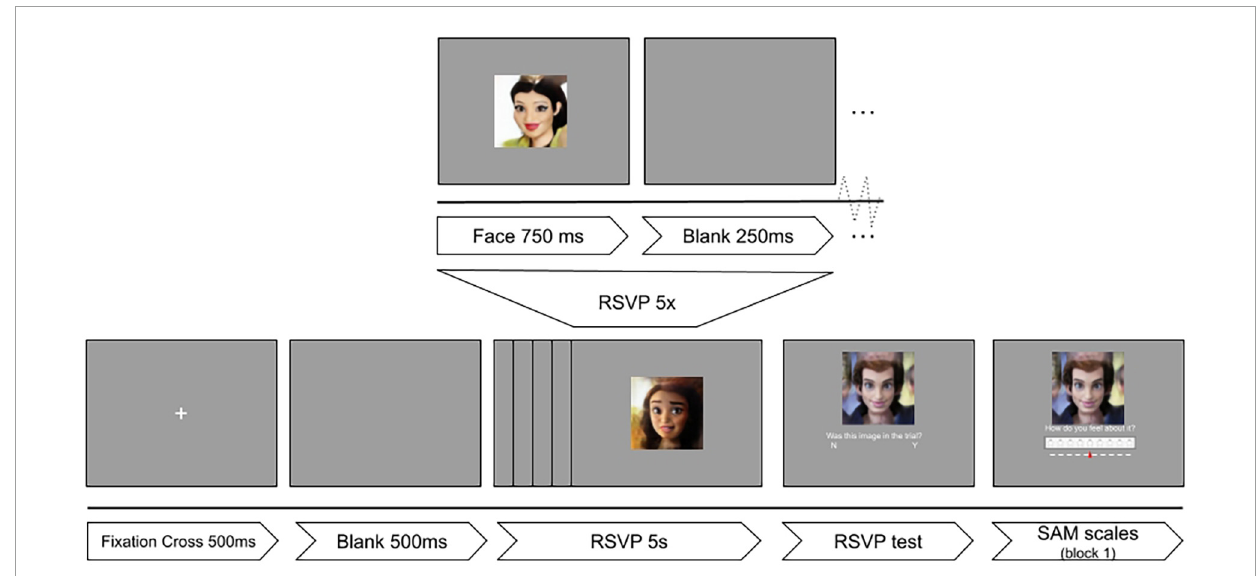
FIGURE1 Experimental timeline of the RSVP protocol. Reproduced with permission from Mollahosseini et al. (2017), available at mohammadmahoor.com/ affectnet/.